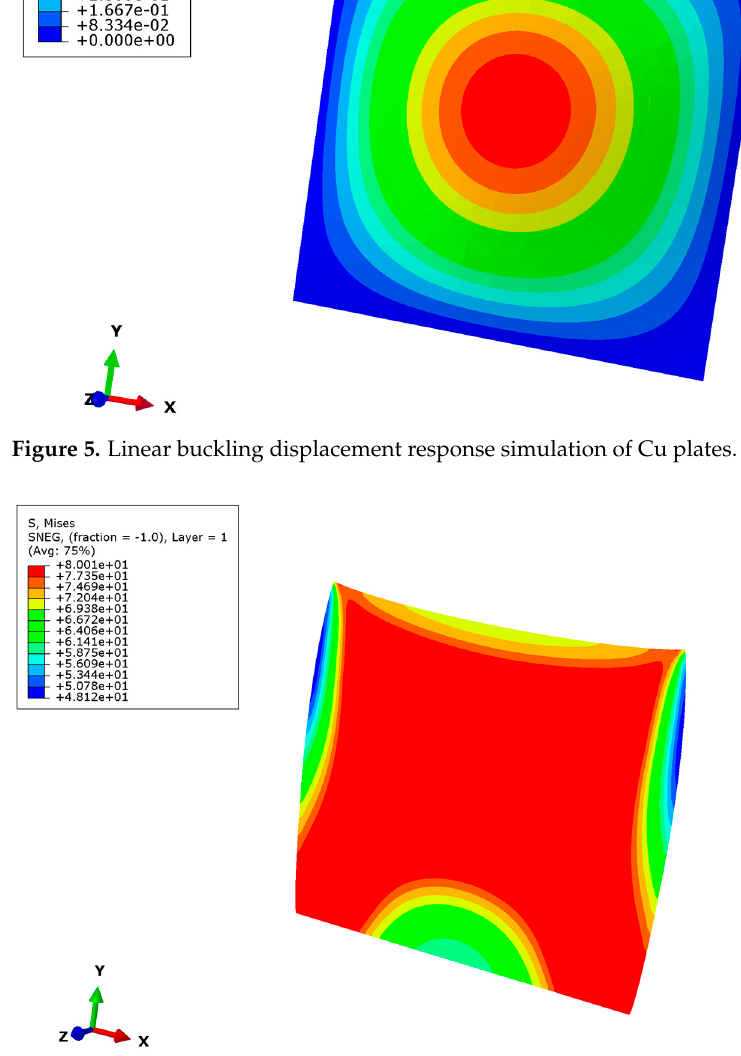
Figure 6. Nonlinear buckling stress response simulation of Cu plates.